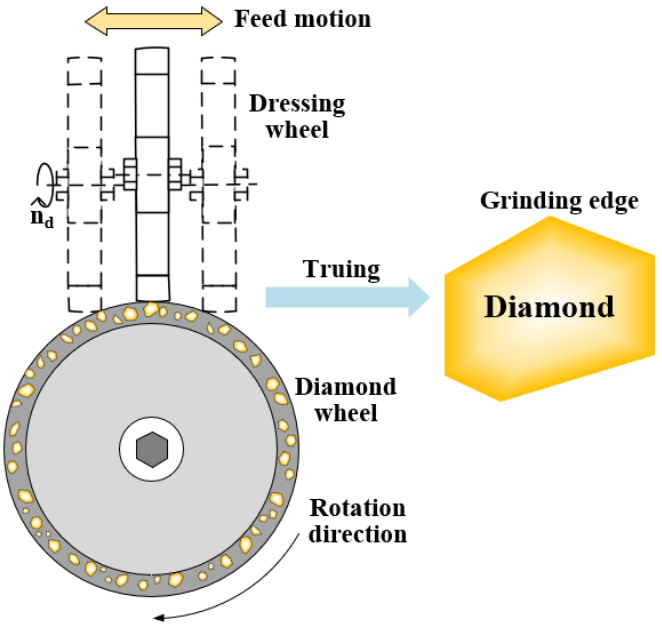
Figure 4. Schematic diagram of the rolling method.